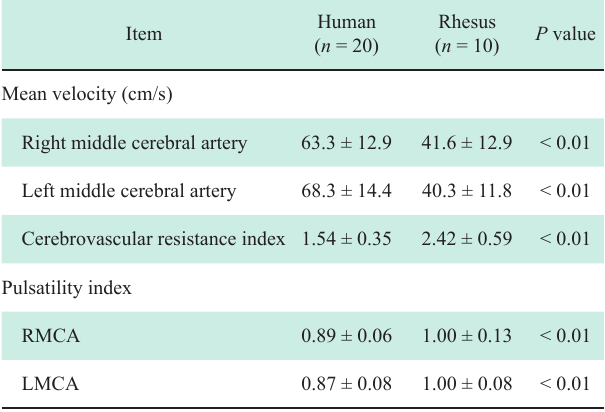
Table 3 Intracranial artery parameters between human and rhesus